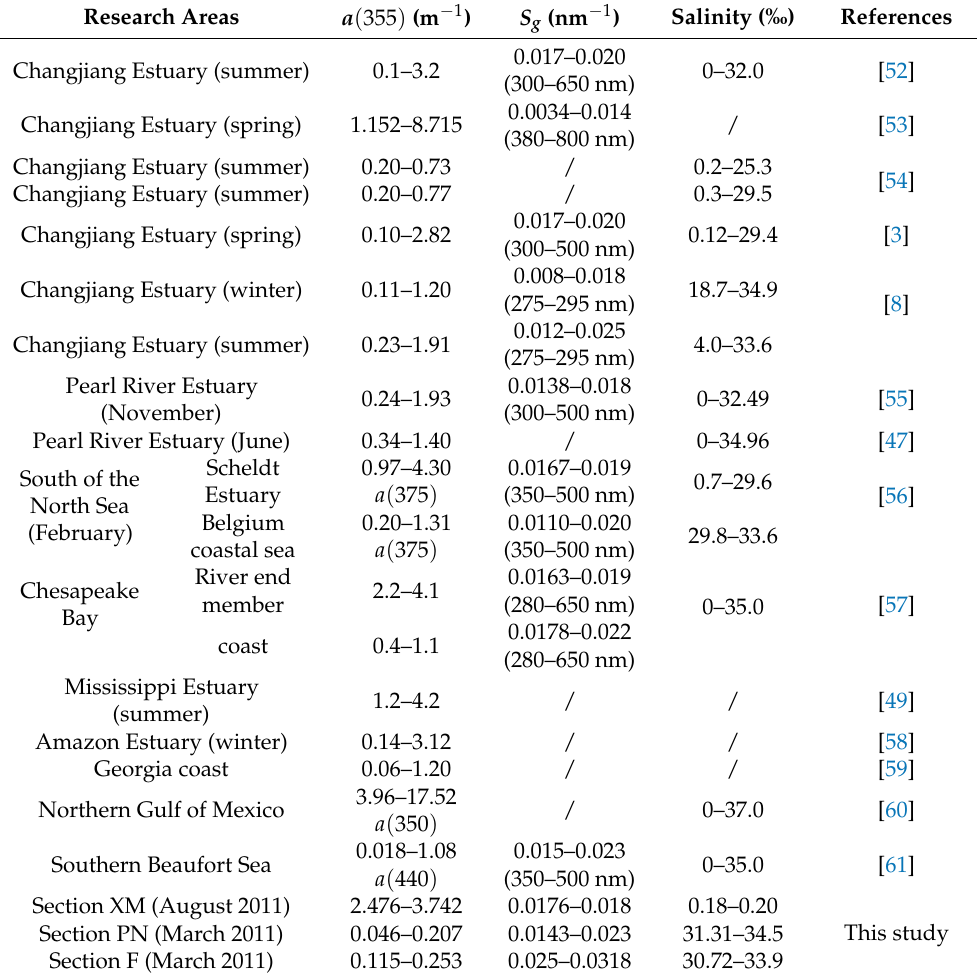
Table 1. Comparison of the a ( 355 ) and S g values of the chromophoric dissolved organic matter (CDOM) from several estuaries around the